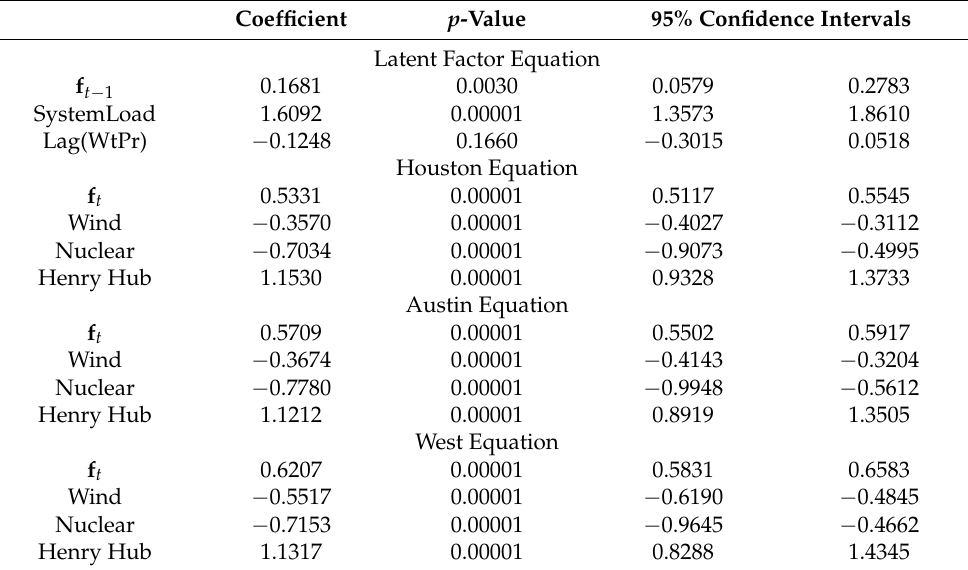
Table 4. ML coefficients for the 4:00 a.m. hour.